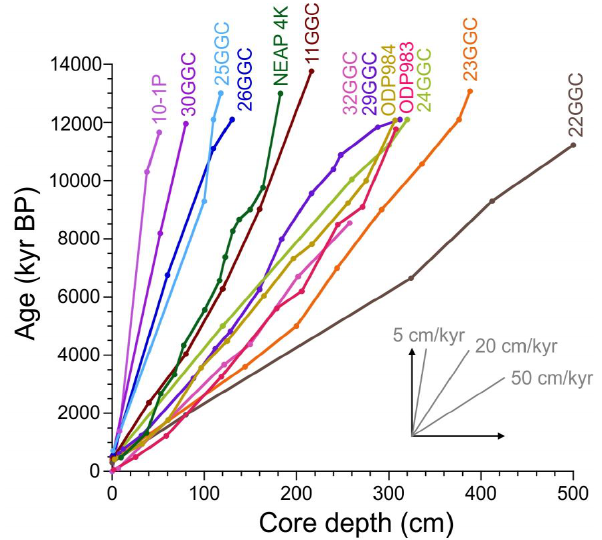
Fig. 2. Age models for sediment cores, based on linear interpolation between age control points.